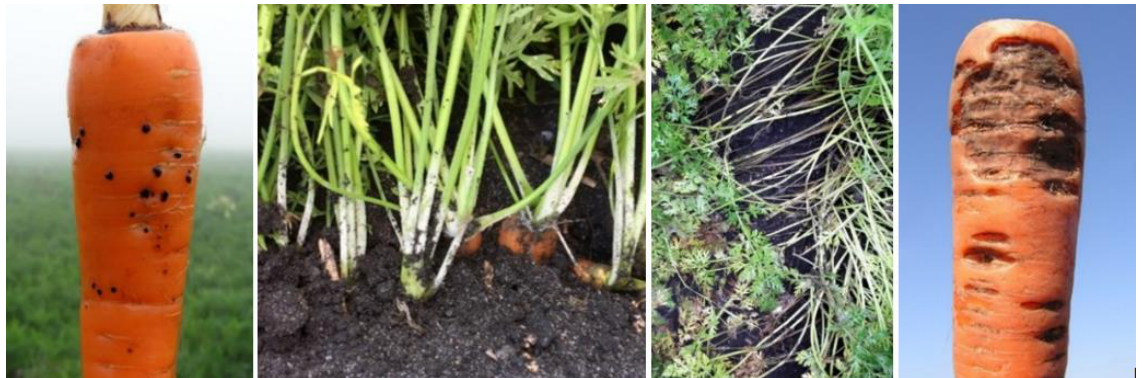
Figure 1. Different types of Rhizoctonia -like symptoms observed in the studied carrot fields, from left to right: black scurf, greyish-white felt-like mycelium, brown wilted stem bases/leaves and crown rot .